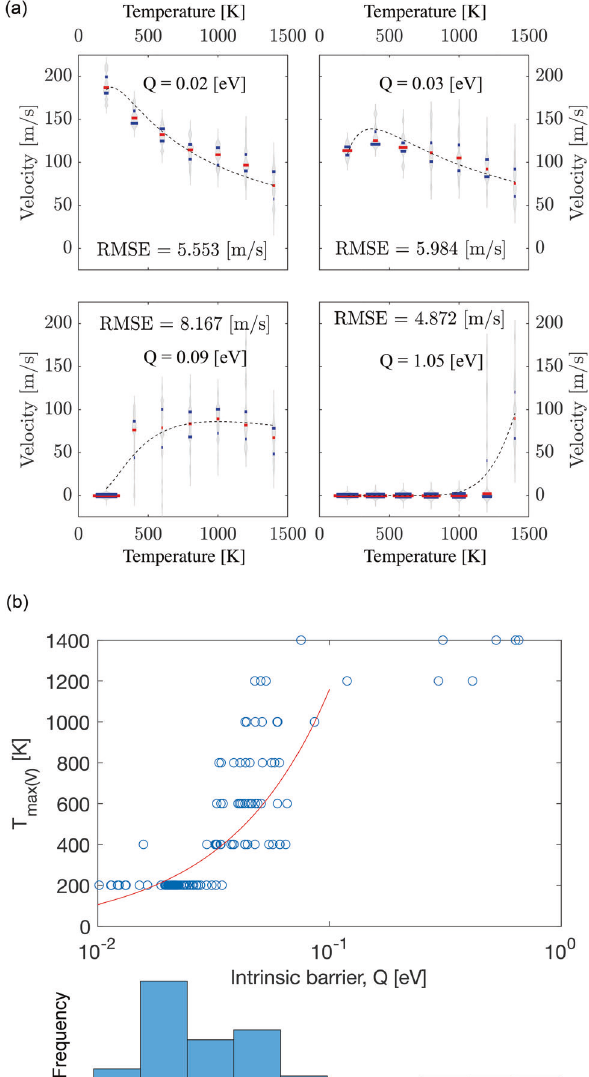
Fig. 2 Metastable boundary migration. a Velocity distributions and corresponding fi t for migration of 4 different metastable structures. b Plot of temperature at which each metastable structure has its maximum velocity as a function of the fi tted intrinsic barrier height Q . Red line is a plot of Eq.